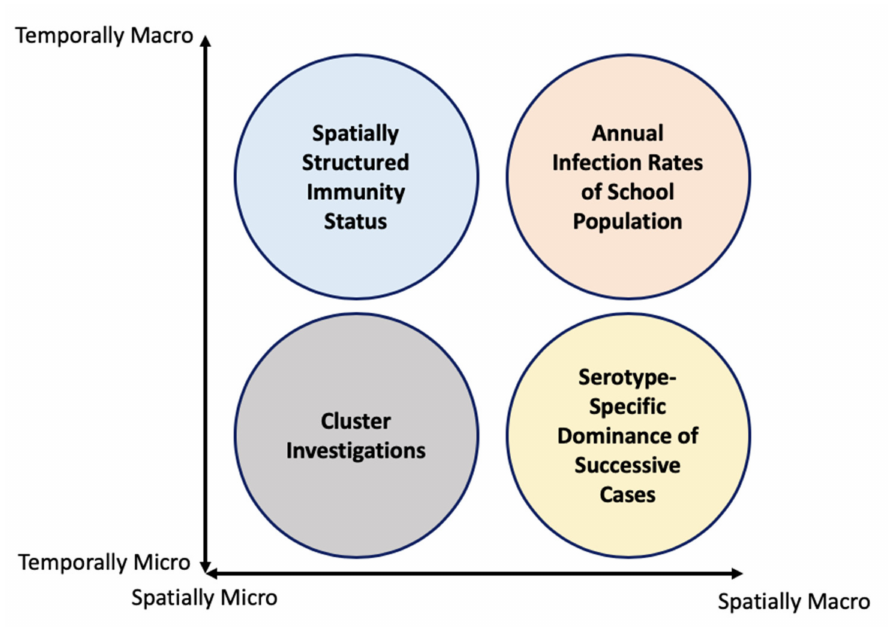
Figure 1. Multiple space-time patterns in spatially explicit ABMs of DENV